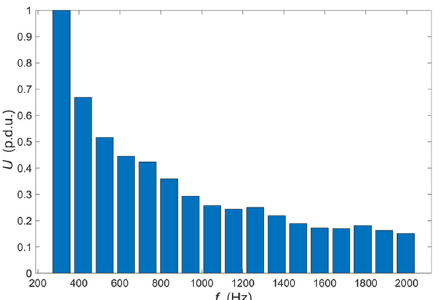
Figure 3. The plot of excitation voltage measured on the output of the D/A converter.